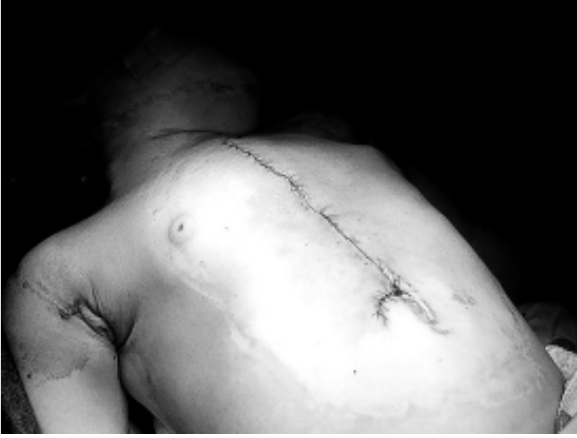
Fig. 2 – Aspecto final após segunda intervenção